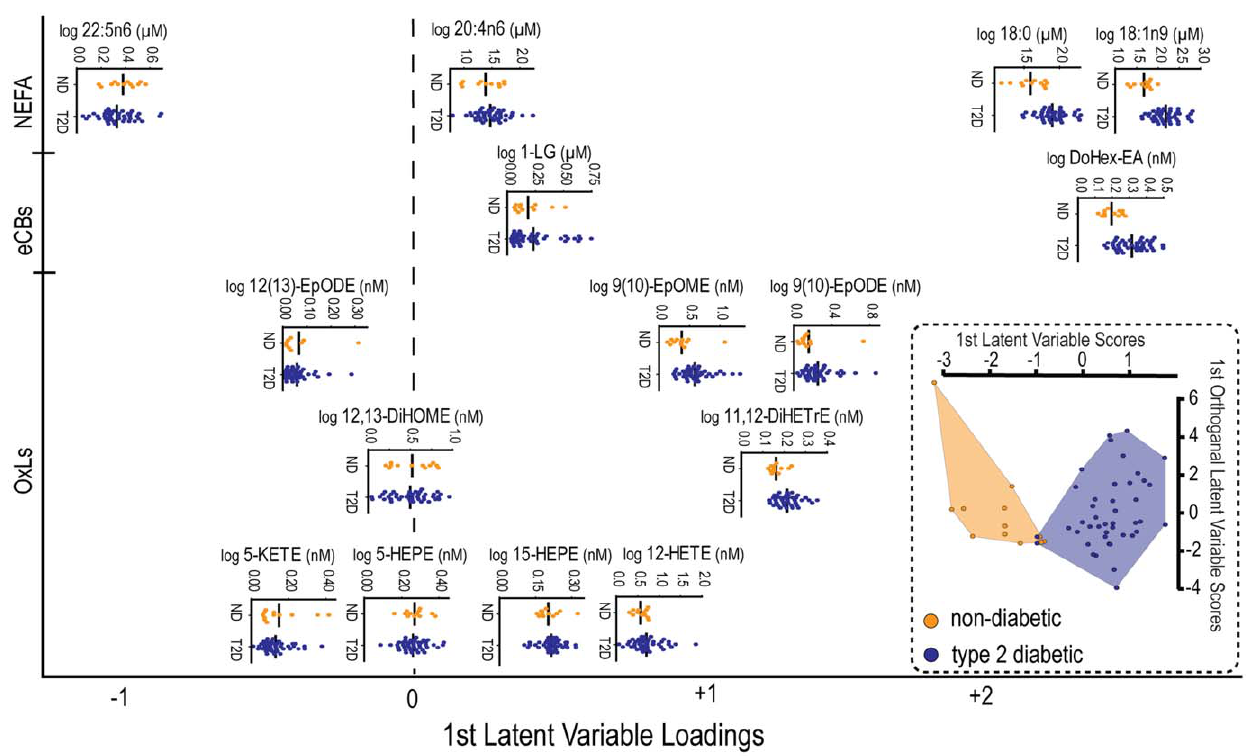
Figure 2. An OPLS-DA model built from 15 plasma lipids discriminates non-diabetic and diabetic cohorts. Horizontal scatter plots of the log transformed concentrations for each model variable are shown. The horizontal arrangement of metabolite scatter plots is scaled to their loading in the discriminant model. A given species importance in the classification increases with increasing displacement from the origin (broken line). The direction of the displacement, left or right, designates whether the species was decreased (left) or increased (right) in the diabetic relative to the non-diabetic patients. The overall model discrimination performance is presented as a scatter plot of subject model scores (inset).